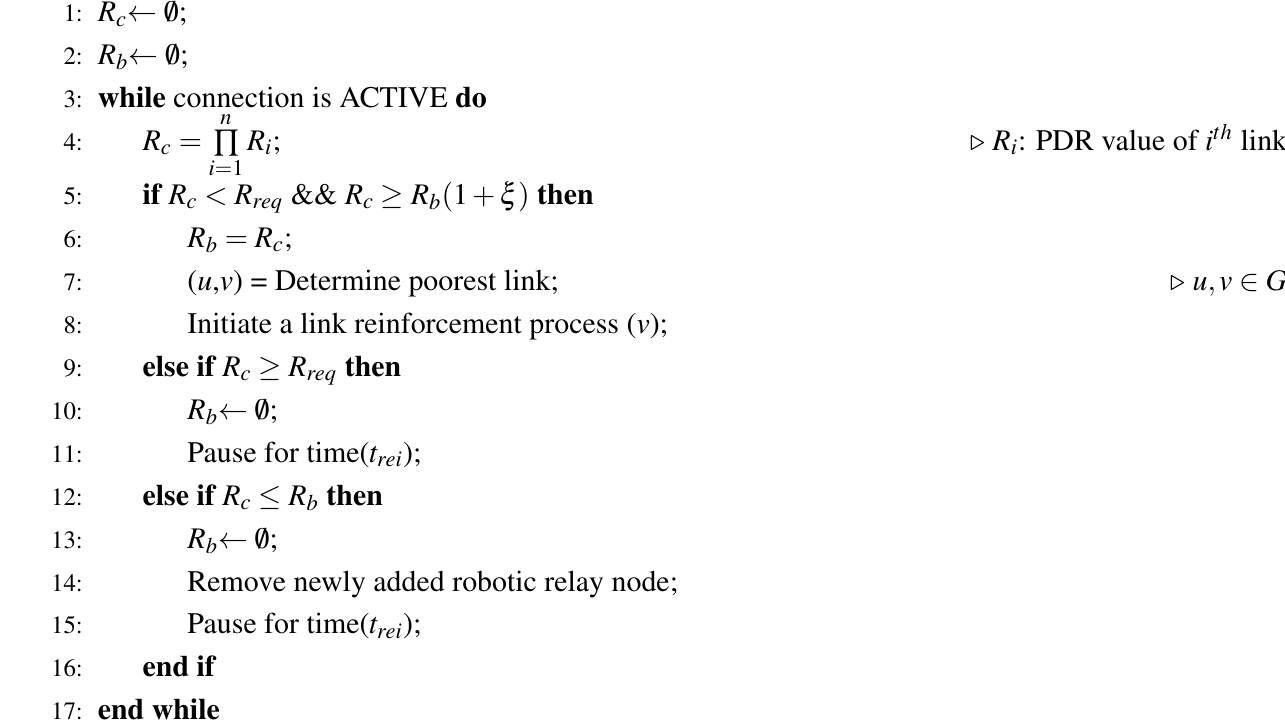
Algorithm 1 Repeated Link Reinforcement Process-Run at destination